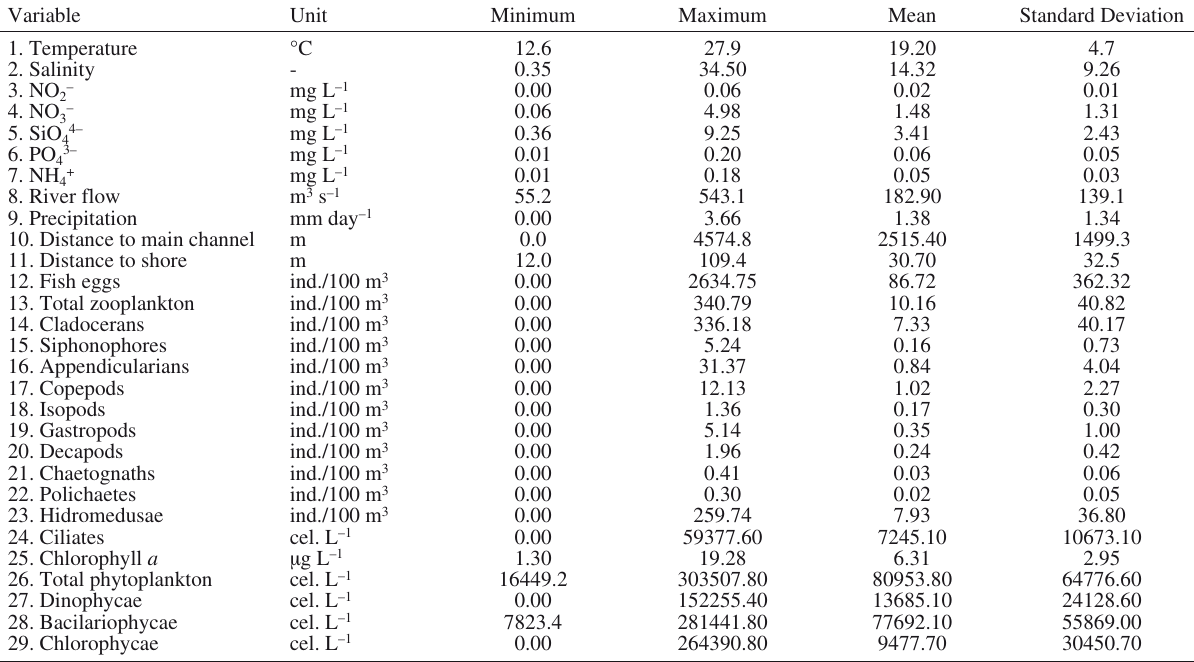
Table 3. – Observed abiotic and biotic variables in the Lezíria salt marsh creek, based on 77 samples.